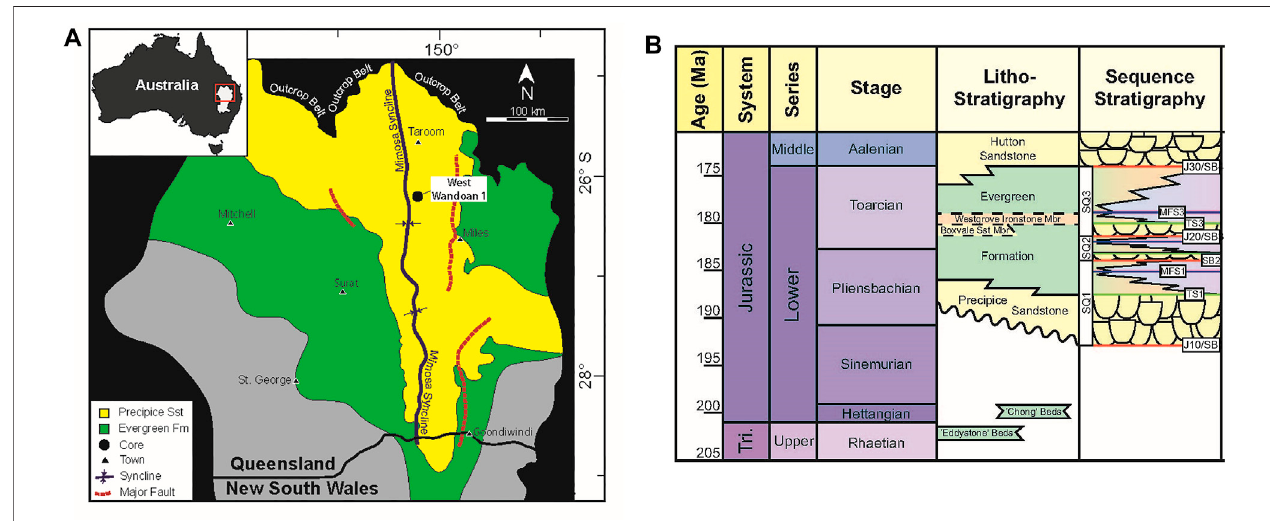
FIGURE 1 | (A) Map of the Surat Basin showing the West Wandoan 1 well. Note that the Evergreen Formation (green) extends over the Precipice Sandstone (yellow). (B) Litho- and sequence-stratigraphy of the Surat Basin where the Precipice Sandstone is the reservoir and the Evergreen Formation is the seal. The map and stratigraphy are modi fi ed after (La Croix et al., 2019a; La Croix et al., 2020b).